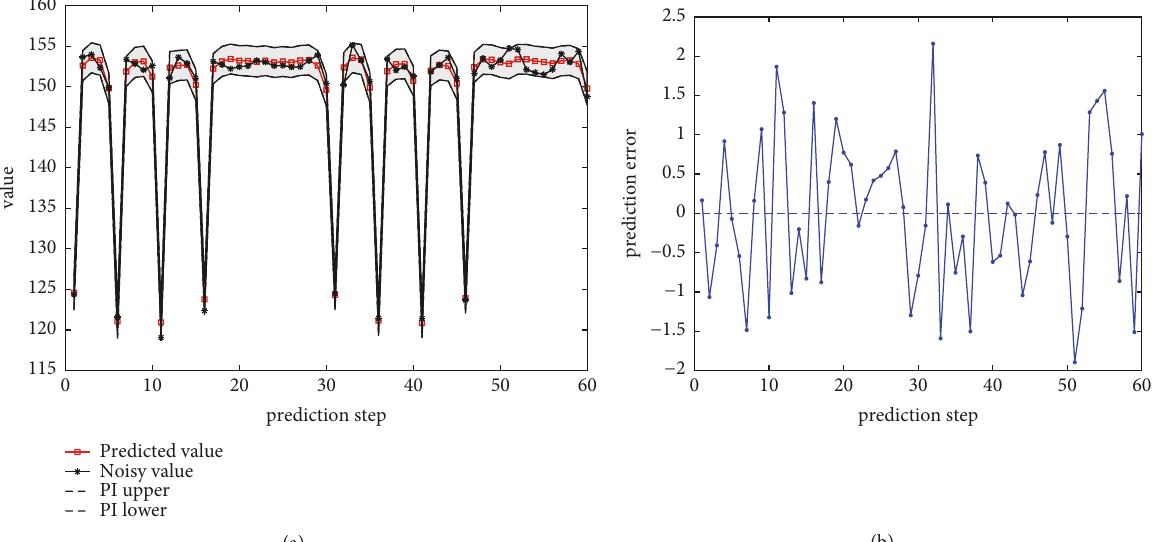
Figure 12: Prediction results for the consumption flow of BFG: (a) the constructed PIs; (b) the corresponding prediction error.